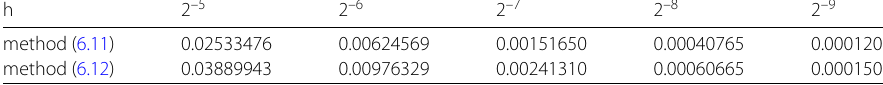
Table 6 The endpoint average sample errors of method (6.11) and (6.12) for solving (6.10) h 2 –5 2 –6 method (6.11)